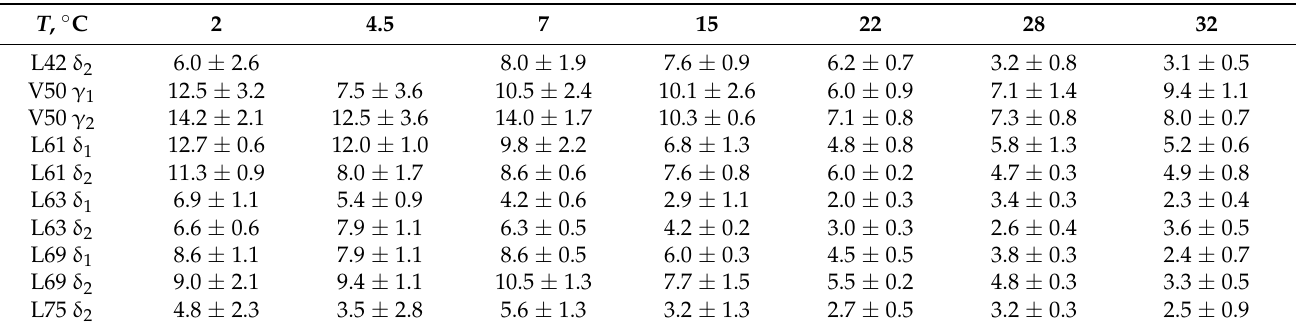
Table 1. List of experimental η HH/CH rates obtained for HP36 perdeuterated/LV protonated protein in the absence of glycerol. The units are s − 1 .